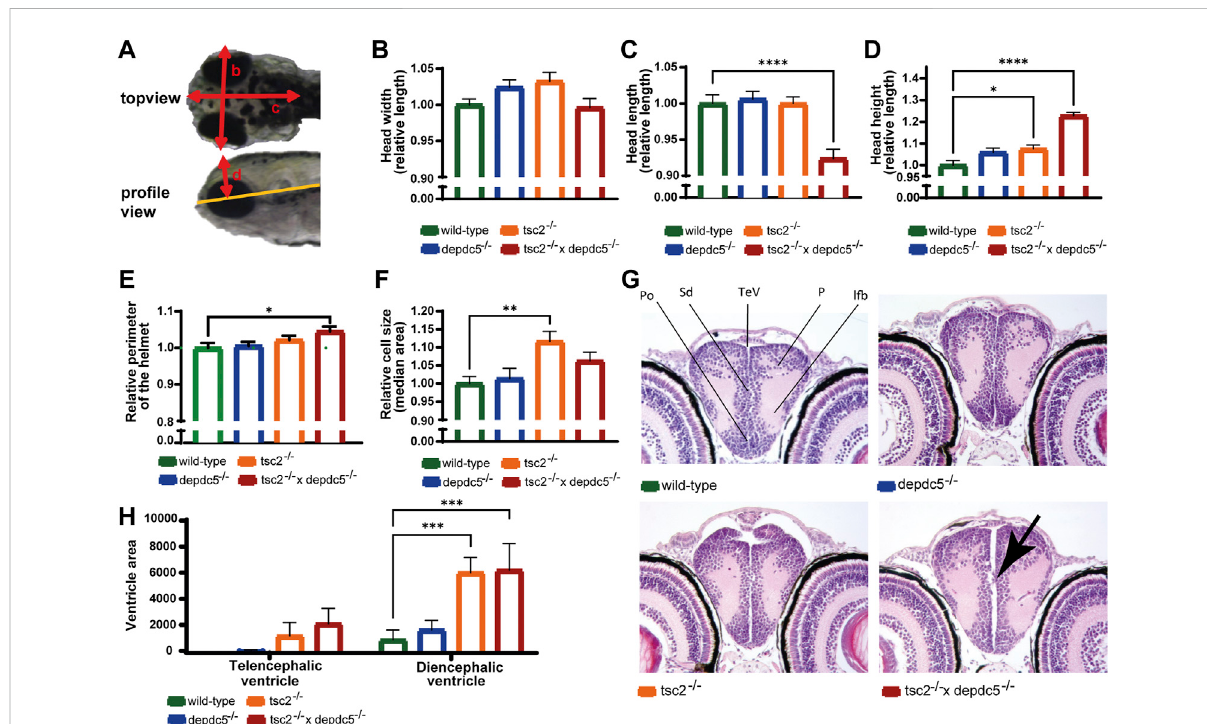
FIGURE 2 Analysis of the brain abnormalities by microscopy and histology. (A) Different head parameters measured in wild-type, depdc 5 – / – , tsc 2 – / – , and double homozygous larvae, with arrows indicating the head width (B) , head length (C) , head height (D) and head helmet (E) . (B – E) Quanti fi cation of theheadwidth (B) ,headlength (C) ,headheight (D) andhelmetperimeter (E) ofwild-type, depdc5 − / − , tsc2 − / − ,anddoublehomozygouslarvaeat5dpf. Absolute lengths were normalized against the wild-type group and relative lengths are reported. Data are presented as mean ± SEM, n = 8 – 11larvae/condition.Signi fi cantvalues(one-wayANOVA)arenotedas**** p < 0.0001,* p < 0.05. (F) Quanti fi cationofthemediancellsizeofEGFP- labelled GABAergic cells in the optic tectum. Data are presented as median ±SEM, n = 12 – 20 larvae/condition. Signi fi cant values (one-way ANOVA) arenotedas** p < 0.001. (G) Representative40ximagesoftheanteriordiencephaloninwild-type, depdc5 − / − , tsc2 − / − anddoublehomozygouslarvae at 5 dpf. n = 4 larvae/group. Black arrow indicates the protrusion of cells into the ventricle. (H) Quanti fi cation of the ventricle area in the pallial and posterior diencephalic area. Data are presented as mean ± SEM, n = 4 larvae/condition. Signi fi cant values (one-way ANOVA) are noted as *** p <